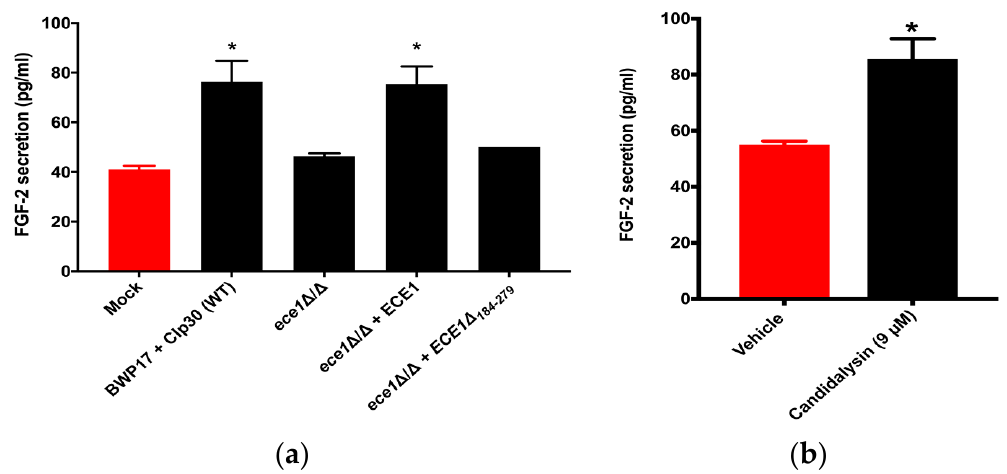
Figure 3. Candidalysin regulates the host endothelial FGF-2 response. ( a ) HUVECs were challenged with BWP17 + CIp30 (WT), ece1 △ / △ , ece1 △ / △ + ECE1 , or ece1 △ / △ + ECE1 △ 184-279 for 24 hours. FGF-2 levels were measured using ELISA. One-way ANOVA was significant ( p = 0.001). Dunnett’s multiple comparison demonstrated that compared to the uninfected group (Mock), only HUVECs challenged with BWP17 + CIp30 or ece1 △ / △ + ECE1 showed a statistically significant increase in the FGF-2 response ( p < 0.05), as indicated by (*). ( b ) HUVECs were treated with vehicle control (water) or Candidalysin peptide for 24 hours. A two-tailed t -test showed a statistically significant difference between the two groups ( p = 0.049), indicated as (*).